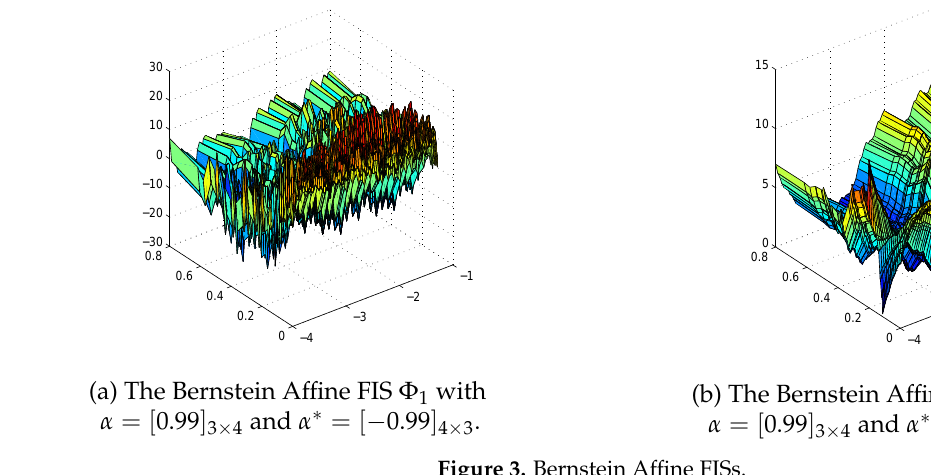
Figure 3. Bernstein Affine